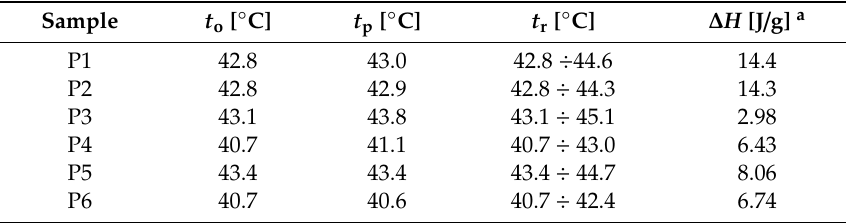
a determined as endothermic peak area calculated per 1 g of solution (concentration of all solutions 1.5% ( w / w )).